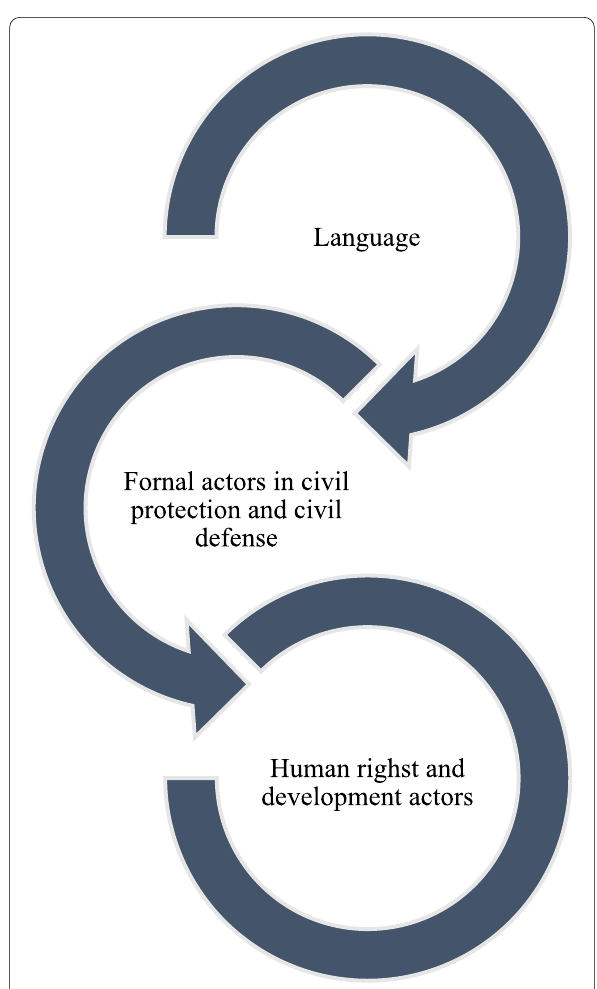
Fig. 1 Shaping factors in determining humanitarian localization. Source: authors’